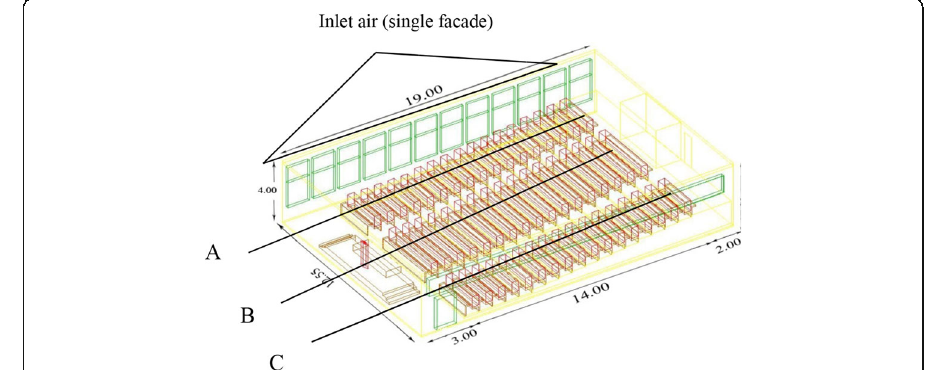
Fig. 1 Description of the model of the case study (source: the